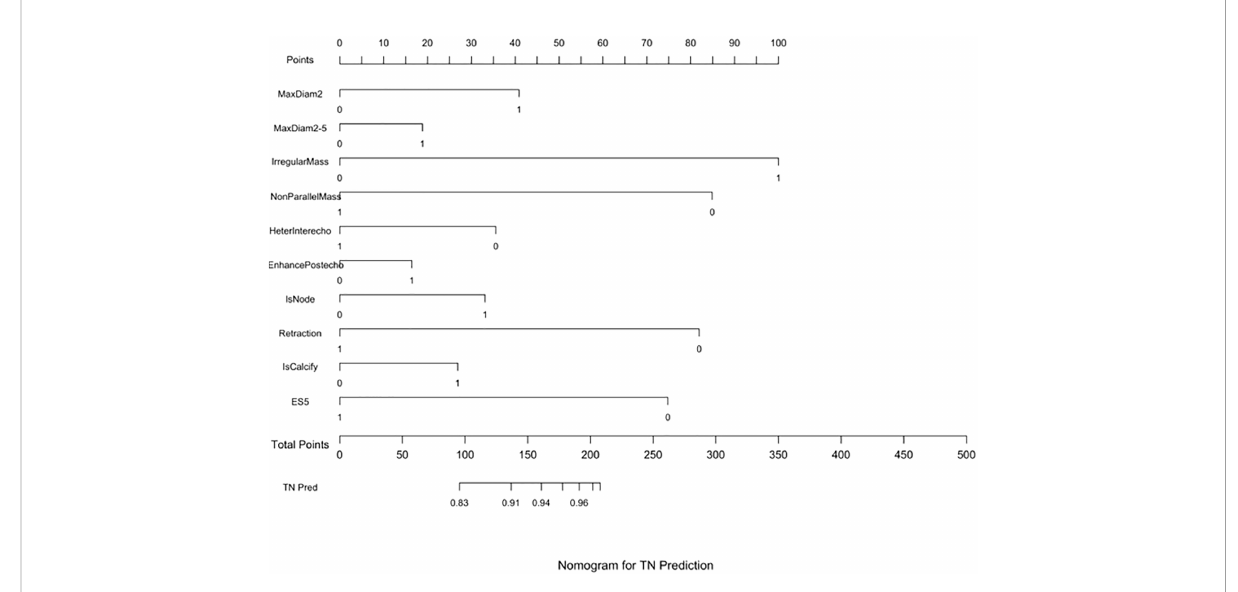
FIGURE 3 TN prediction nomogram. Nomograms were constructed based on the results of the multivariate logistic regression mode